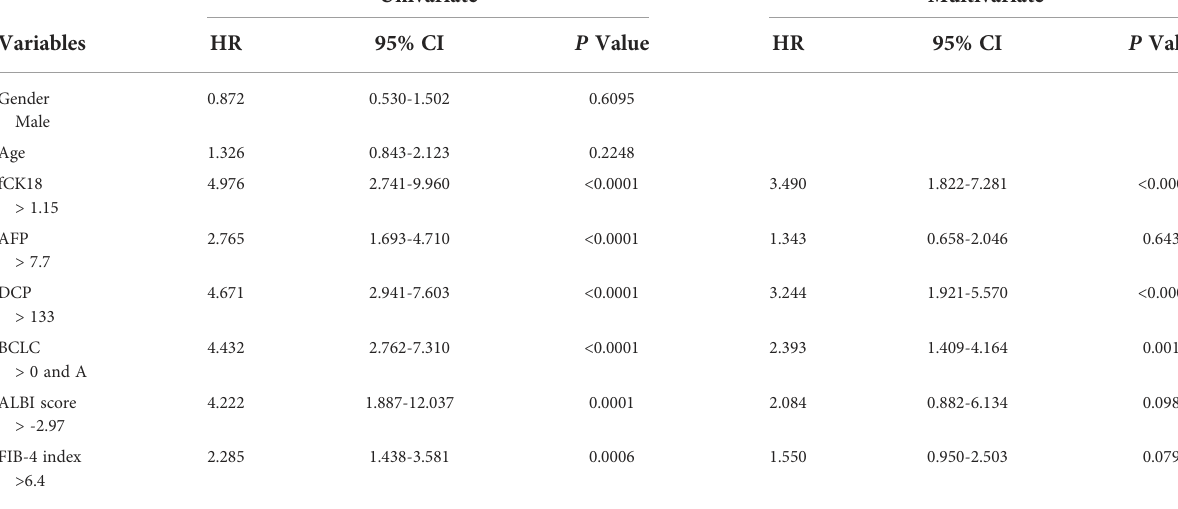
TABLE 3 Univariate and multivariate Cox regression analysis for predictors of survival in HCC patients. Univariate